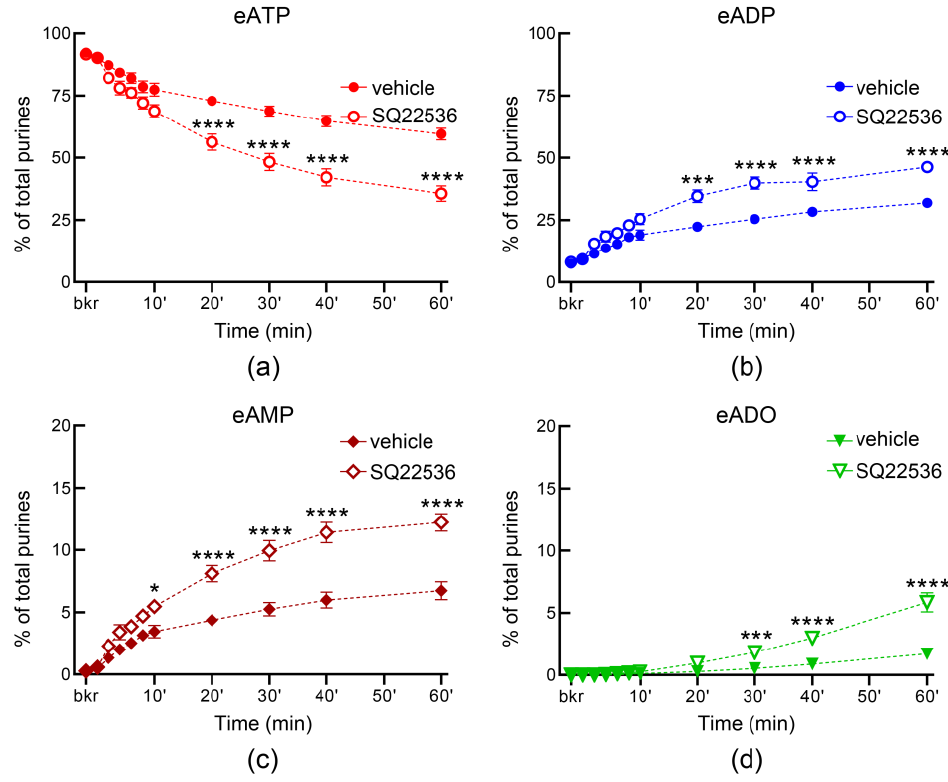
Figure 10. Effect of SQ22536 on the hydrolysis of eATP by soluble nucleotidases released in the lamina propria of nondistended denuded bladder preparations. Time courses of eATP decrease ( a ), eADP increase ( b ), eAMP increase ( c ), and eADO increase ( d ) after addition of eATP to concentrated ELS collected from nondistended (empty) preparations. Note that the degradation of eATP was enhanced in the presence of SQ22536 (100 µ M, n = 3) in comparison to DMSO 0.2% control ( n = 4); n , number of bladder preparations. * p < 0.05, *** p < 0.001, **** p < 0.0001 vs. vehicle controls. 2 way ANOVA with Sidak’s multiple comparisons